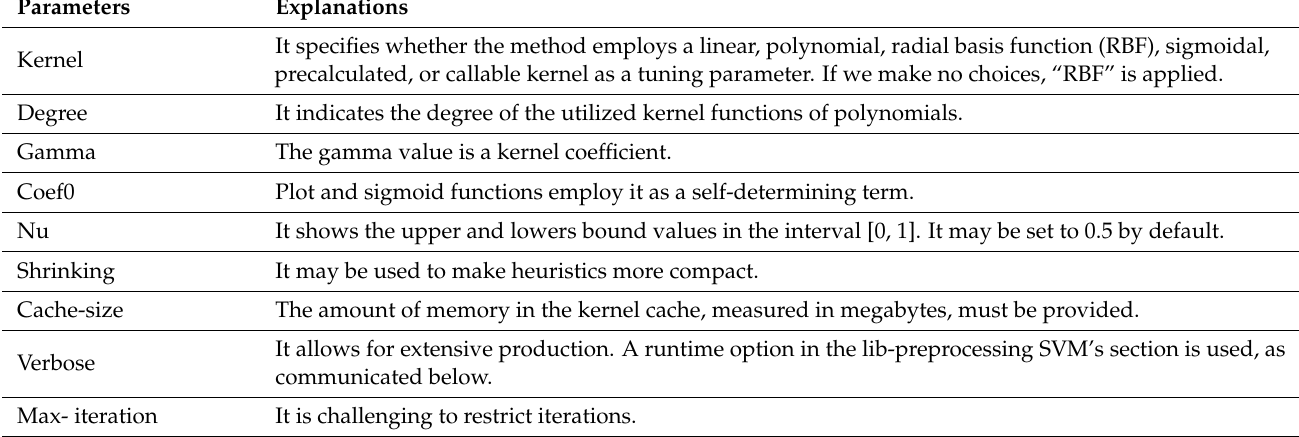
Table 7. Key parameters used in support vector machine.